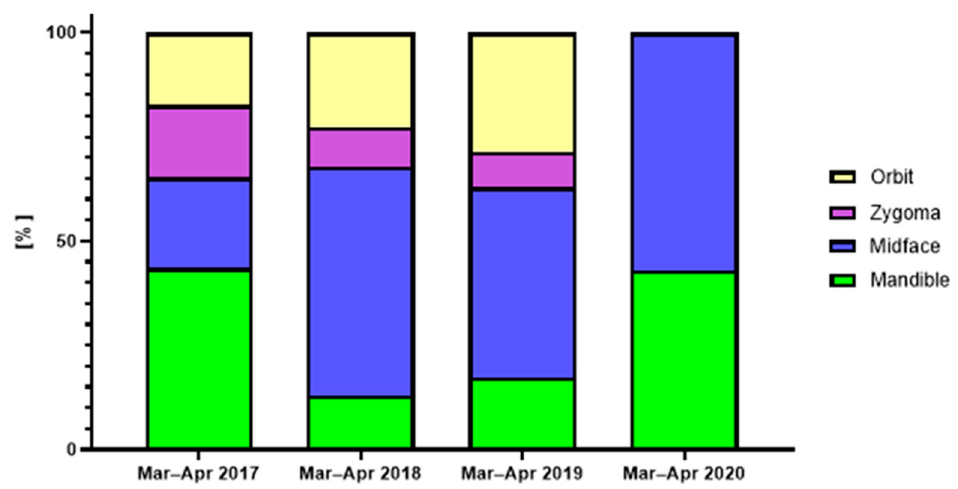
Figure 6. OMF fractures according to the site of injury in the patients admitted to the GMC trauma center during March and April in the years